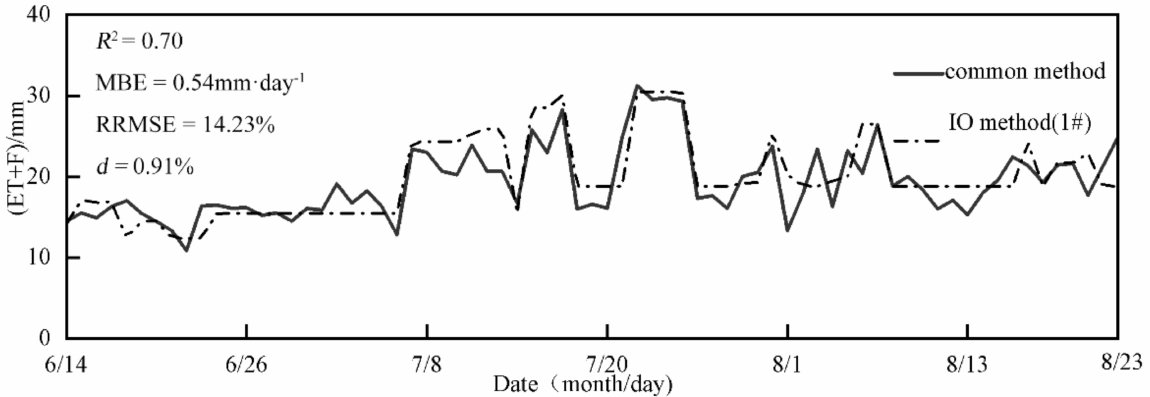
Figure 4. Comparison of ET+F in paddy fields between the common method and IO